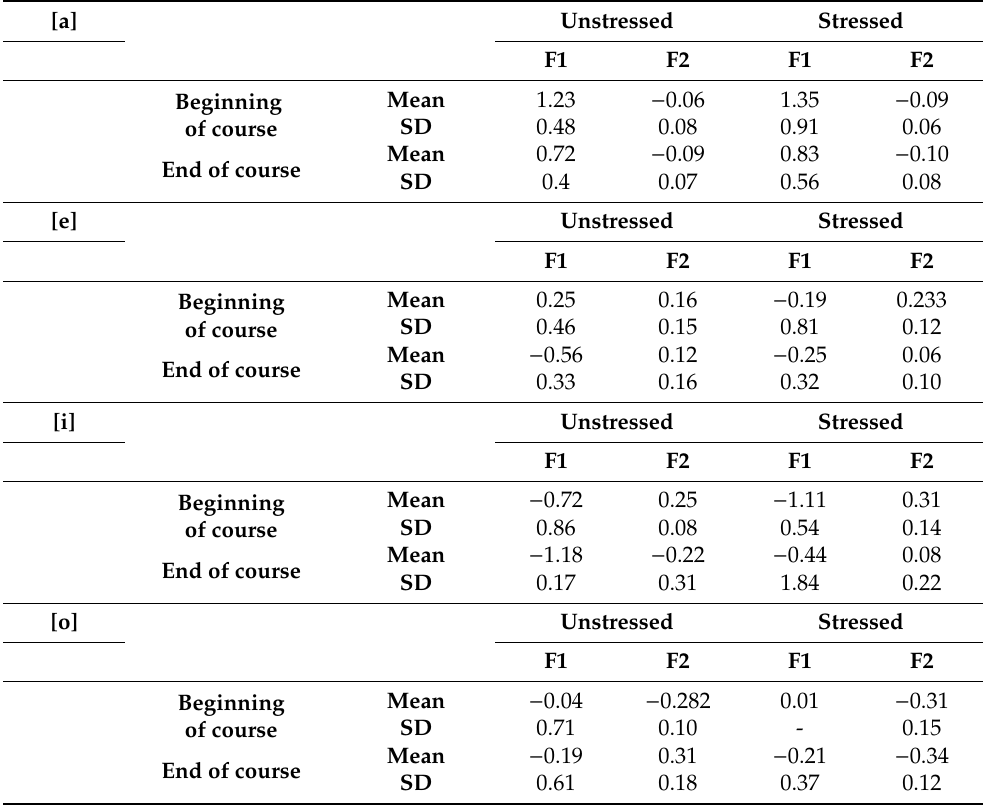
Table 3. Mean formant values for vowels produced by Informant